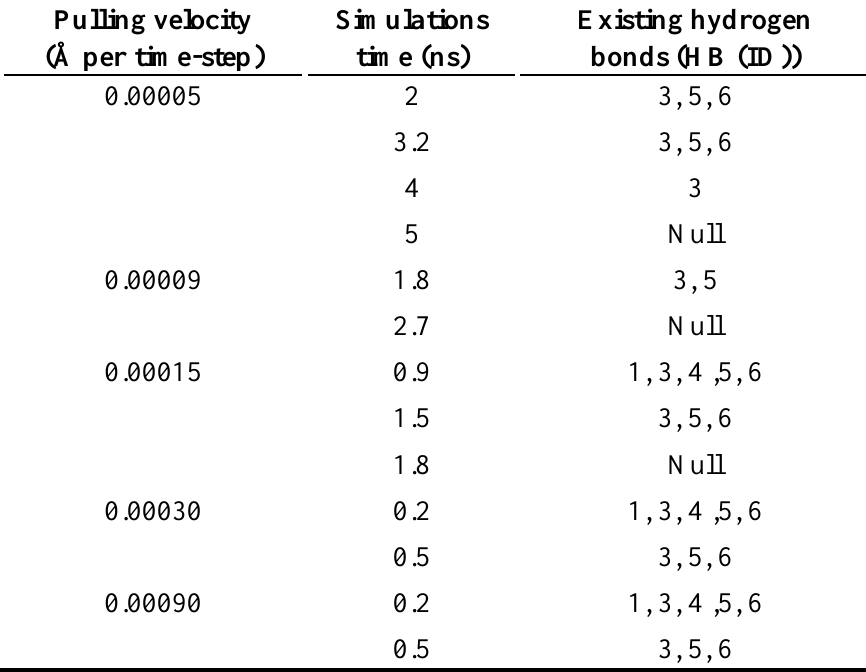
Table 3. The hydrogen bonds trajectories and